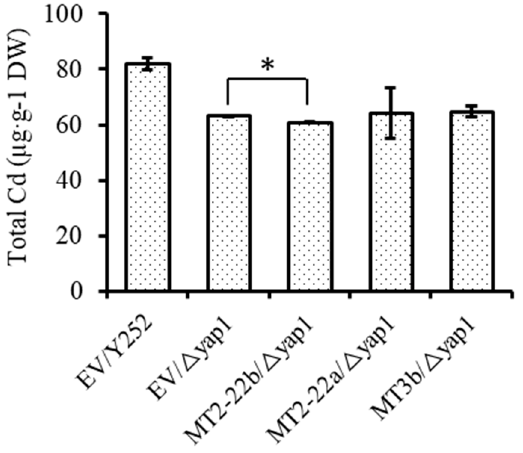
Figure 5. Total Cd accumulation in yeast transformants. Data are mean ± SD, n = 3. Statistical significance was indicated by * (Student’s t test, p < 0.05).